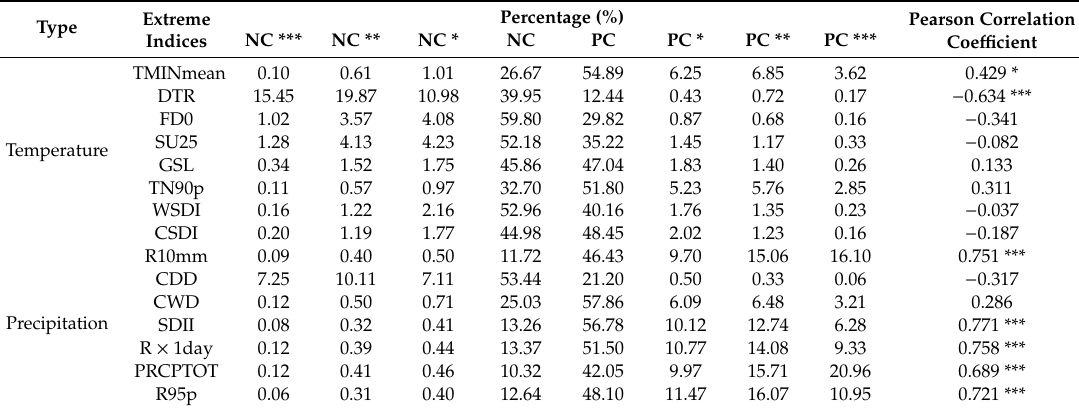
Table 6. Statistics of the correlations between the GNDVI and extreme climate indices in the vegetation coverage area (VCA) of